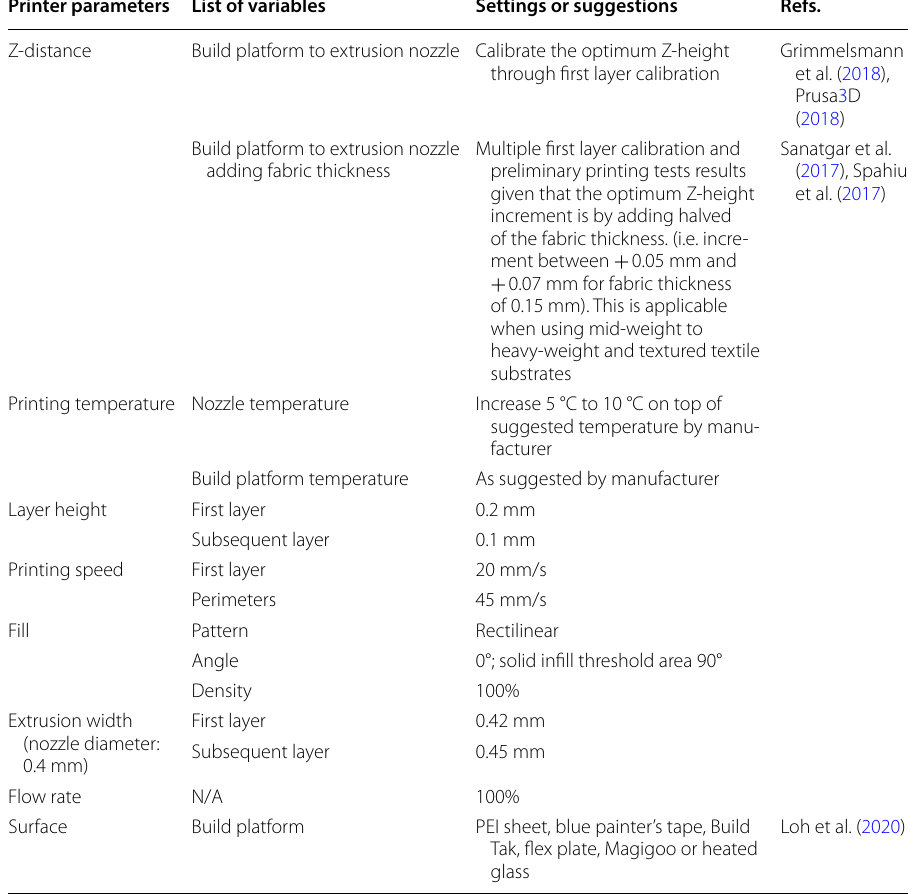
Table 5 The list of ME printer settings taken into consideration during the fabrication of the polymer–textile